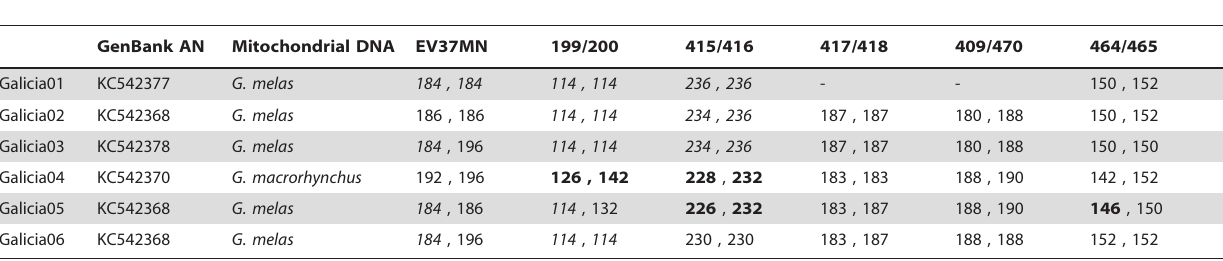
Table 3. DNA markers of the stranded pilot whales analyzed.